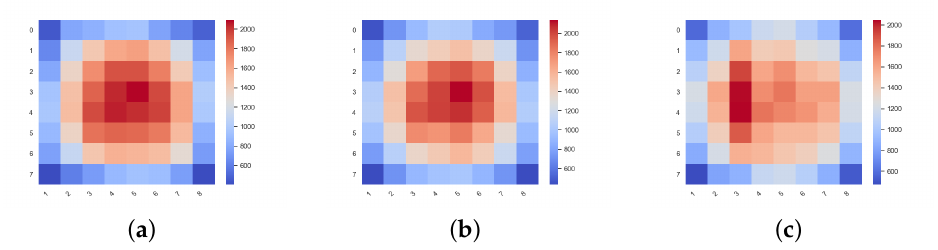
Figure 10. The crossbar activity of each node on an 8 × 8 2D Mesh network for different routing algorithms. The red to blue represents the crossbar activity from high to low. The more activity a crossbar is, the heavier loading the node has. ( a ) XY. ( b ) FreeRider. ( c )